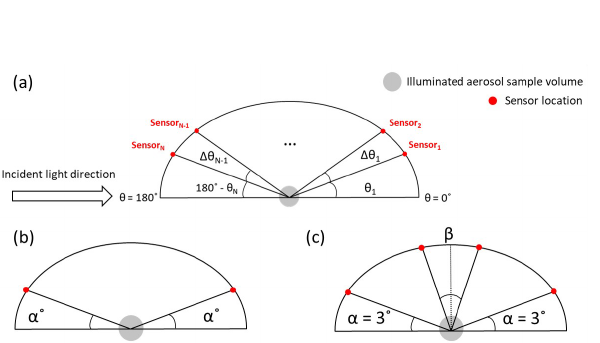
Figure 2. Schemes of scattering measurement geometry: (a) po- lar angles of sensors, (b) truncation around extreme angles, and (c) truncation around right